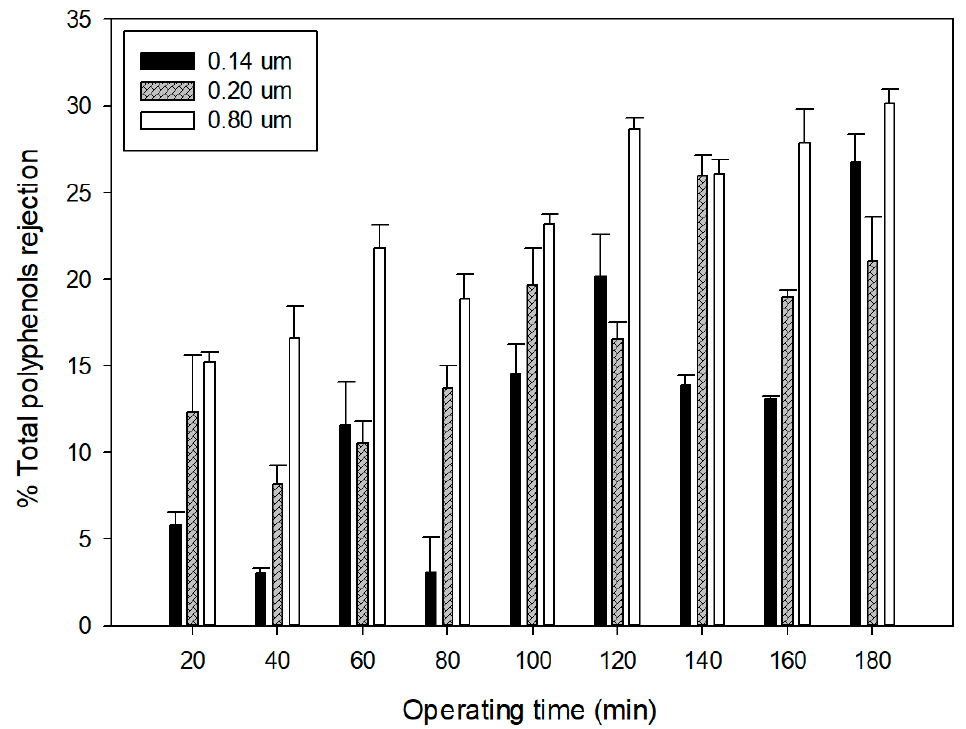
Figure 7. Rejection of MF membranes towards total phenols.